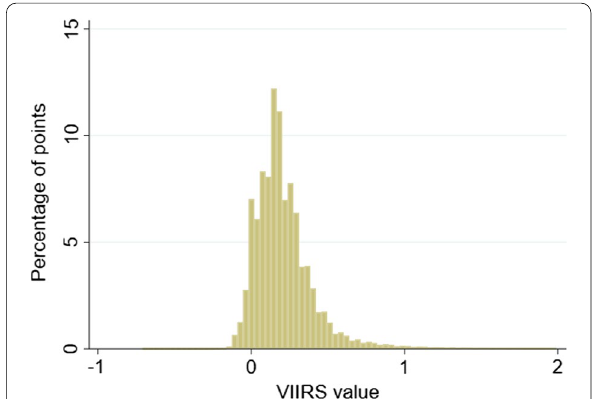
Fig. 2 VIIRS value distribution for VIIRS values below 2 Fig. 3 Days with no cloud cover in a month across all months. The X-axis shows how many days per month that were cloud free, i.e. that had a light value measurement. The Y-axis shows the distribution of number of cloud free days per month. Adding up all columns equal